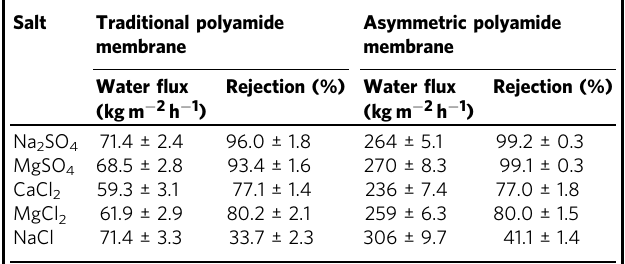
Table 2 Separation performance. Salt Traditional polyamide membrane